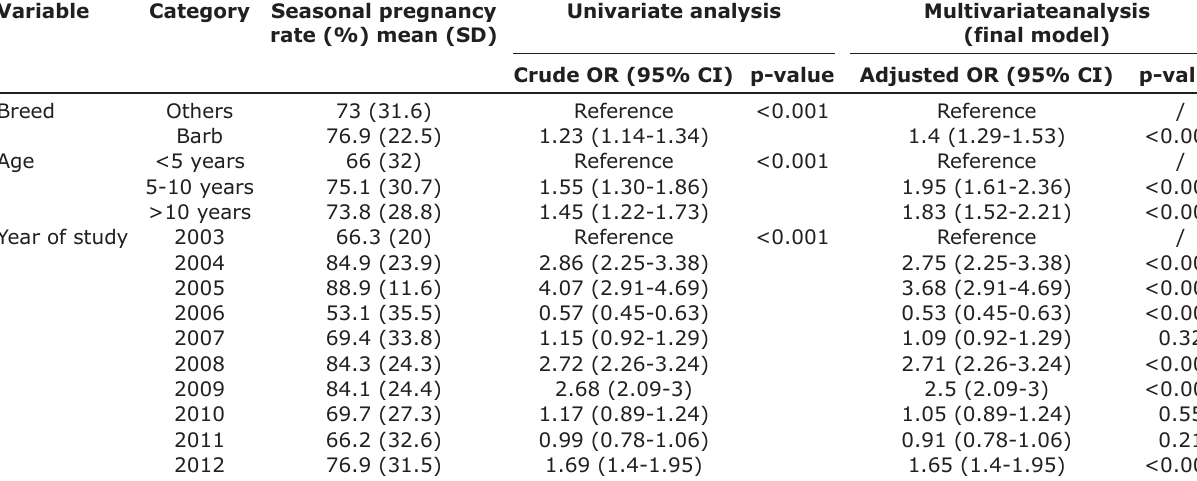
Table-5: Influence of breed, age of stallion, and year of study on seasonal pregnancy rate.